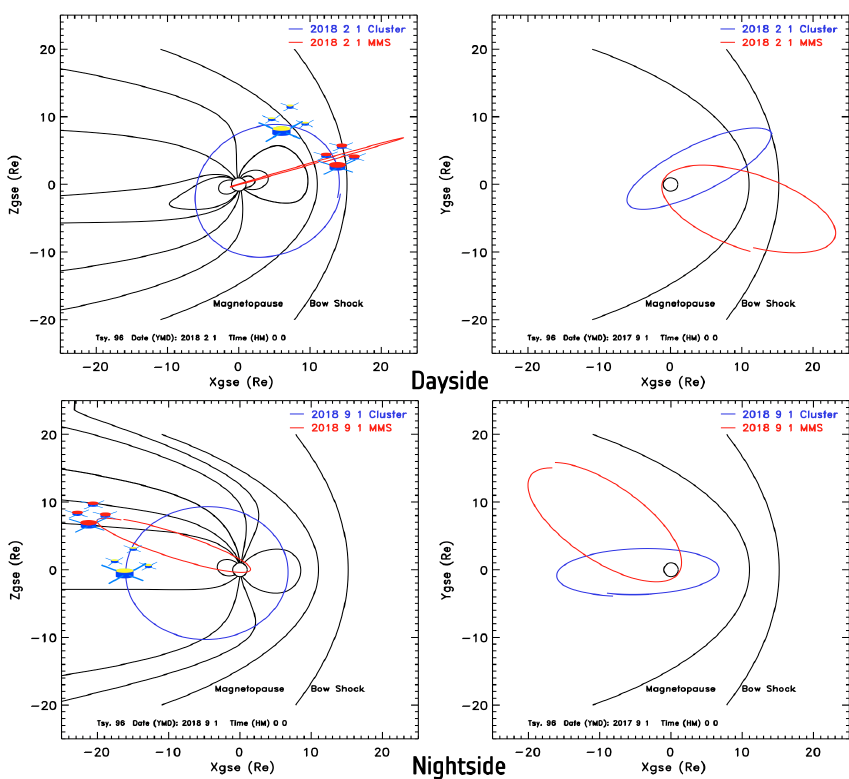
Figure 3. Cluster and MMS orbits on 1 February 2018 in XZ GSE (top left) and XY GSE (top right). Cluster and MMS orbits on 1 September 2018 in XZ GSE (left) and XY GSE